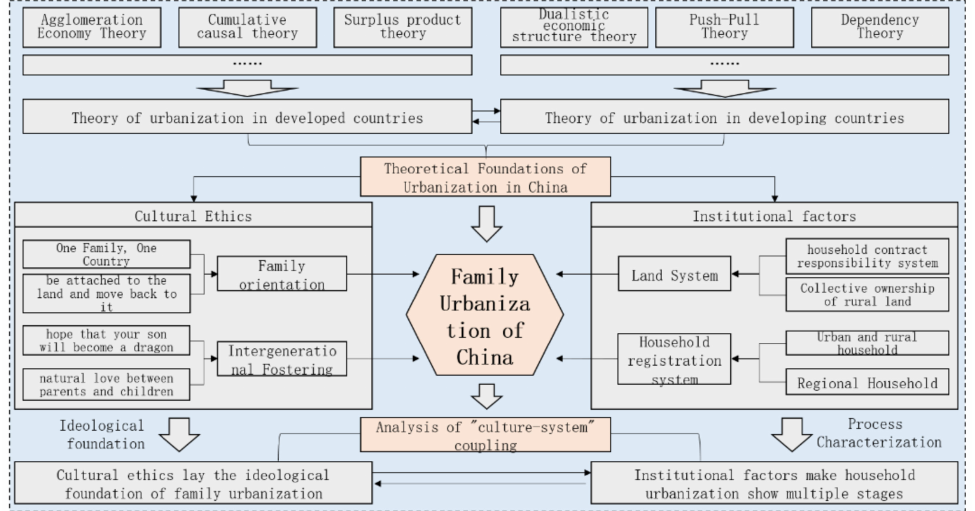
Figure 7. Family urbanization model